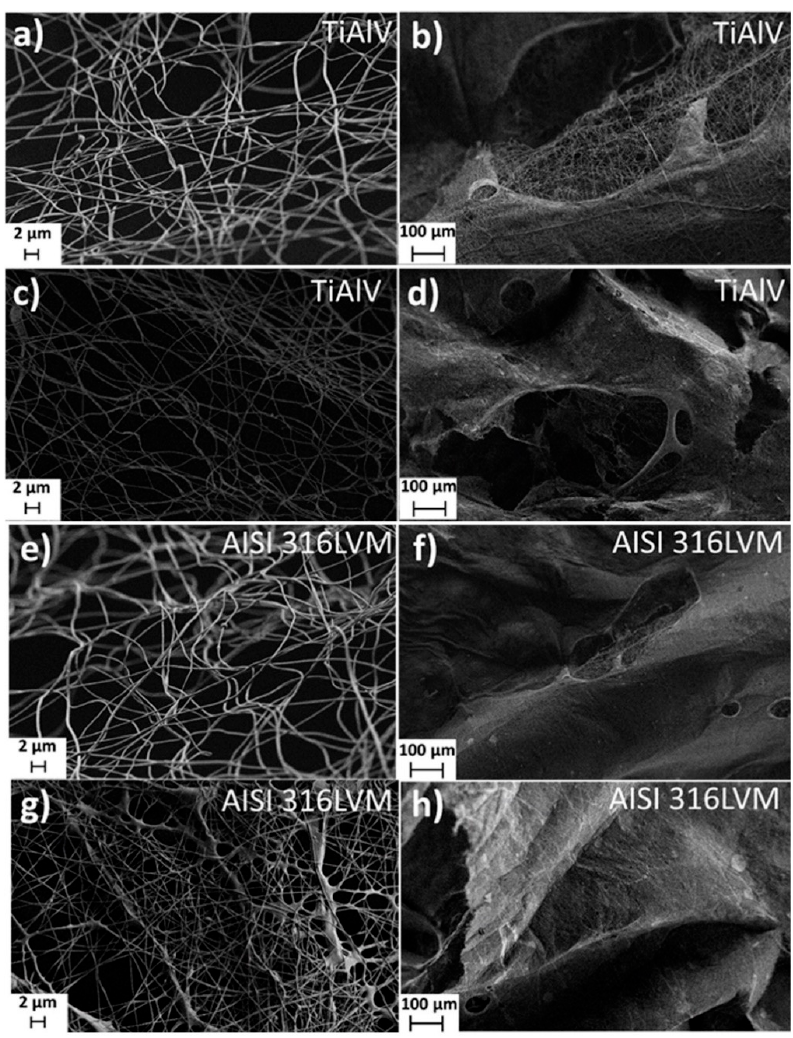
Figure 2. FE-SEM images of the non-functionalised ( a , b , e , f ) and CLIN-functionalised ( c , d , g , h ) ES on TiAlV ( a – d ) and ES on AISI 316LVM ( e – h ). Microphotographs were taken at different magnifications.